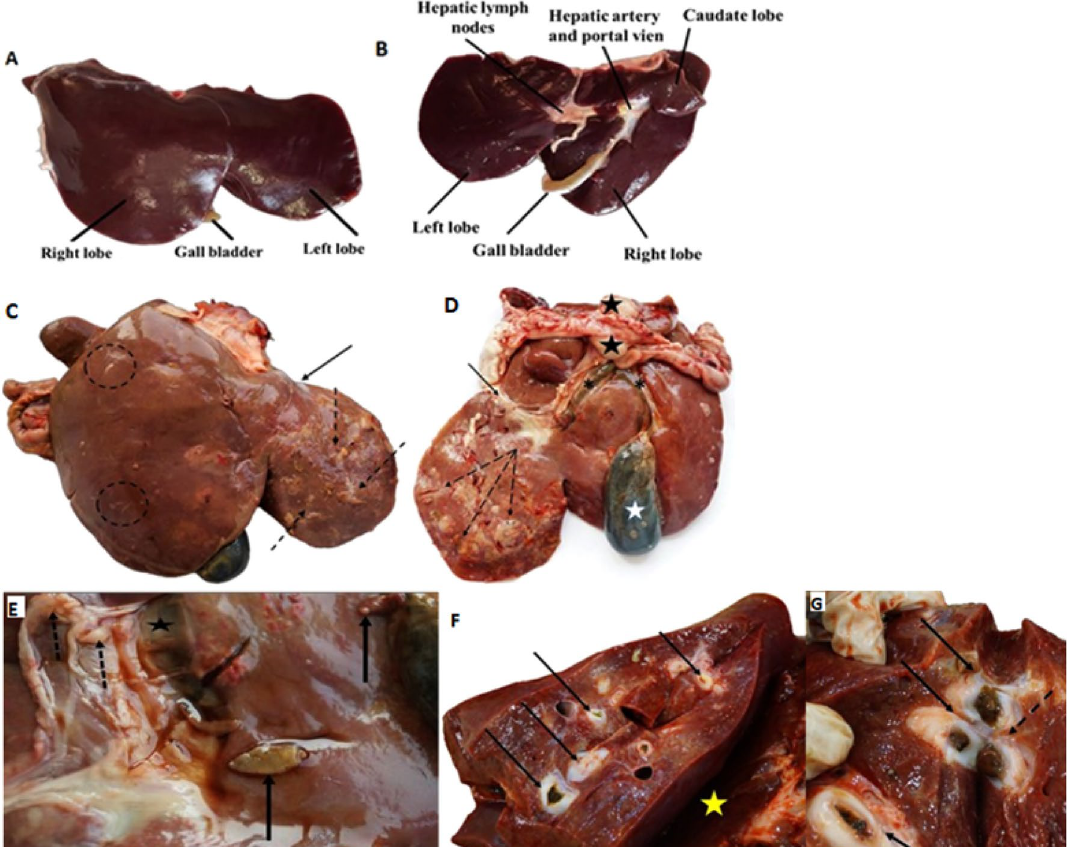
Figure 3. Normal liver morphology, ( A : diaphragmatic surface view; B : visceral surface view). ( C ) The diaphragmatic surface of the infected liver showing lobular enlargements, thickened capsule (black arrows) and patches of fibrosis (dotted arrows). The migratory paths of worms can also be seen (dotted circles); ( D) the visceral surface of the infected liver showing marked necrotic regions or abscess formation (dotted arrows). Note the engorgement of the gallbladder (white star), dilated bile ducts (asterisk) and enlarged portal lymph nodes (black stars); ( E ) mature and immature Fasciola flukes on the surface (black arrows), dilated bile ducts (black star) and enlarged portal lymph nodes (dotted arrows); ( F ) cut a section from infected liver showing fibrotic thickening and hyperplasia of the portal bile ducts (black arrows). Hemorrhagic foci (yellow star) were also presented; ( G ) cut a section from infected liver showing calcification and thickening of the bile ducts filled with debris (black arrows) and Fasciola fluke (dotted arrow) protruding from another bile duct can be